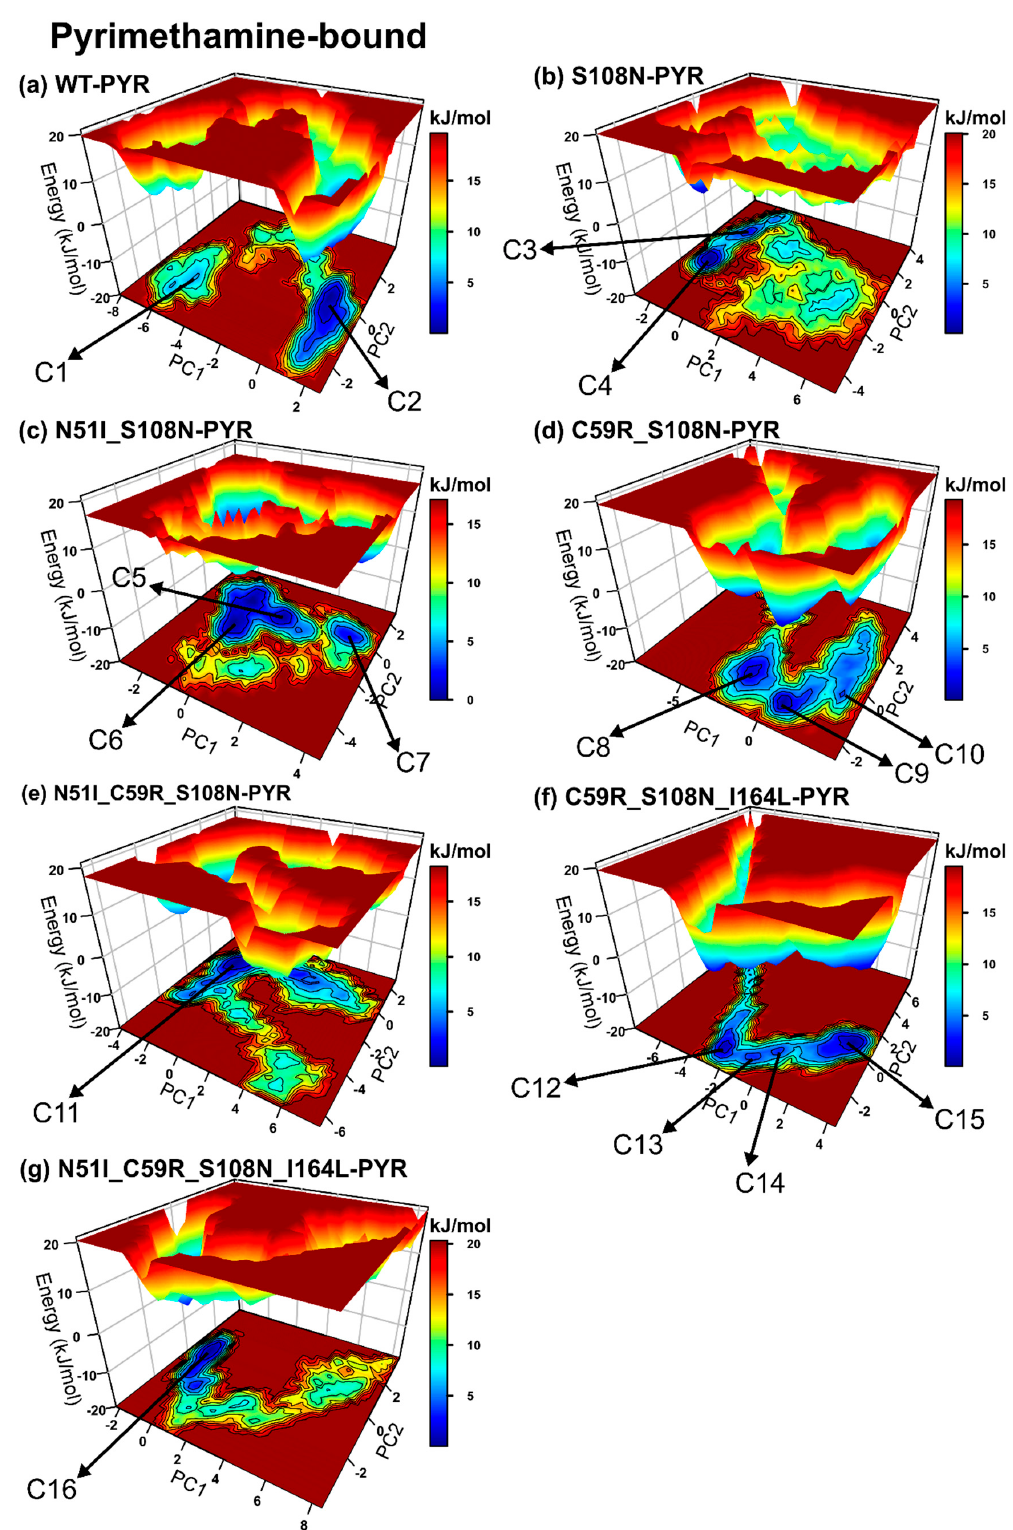
Figure 4. Free-energy landscape plots of pyrimethamine-bound systems: Perspective view of free-energy landscape as a function of the first two principle components (PC1 and PC2). The landscapes were color coded from maroon (energy maxima) to blue (energy minima). Conformations sampled are labeled C1–C16.